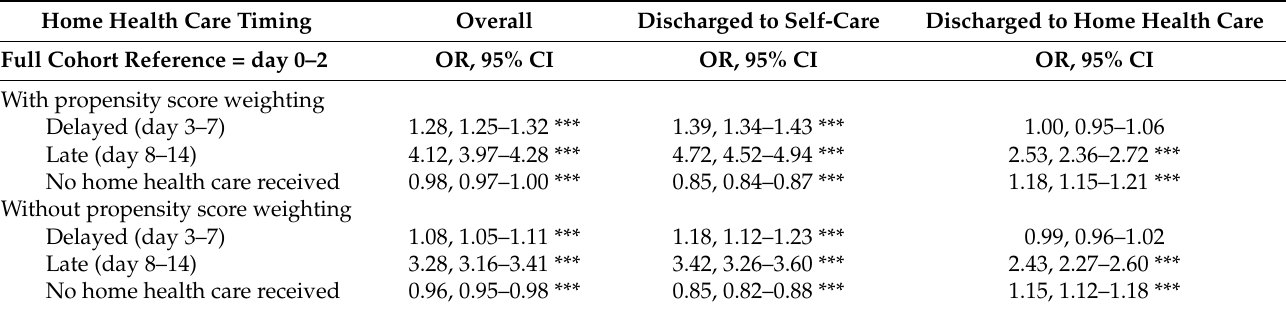
Table 2. Results of weighted and unweighted logistic regression predicting 30-day all-cause rehospitalization stratified by discharge